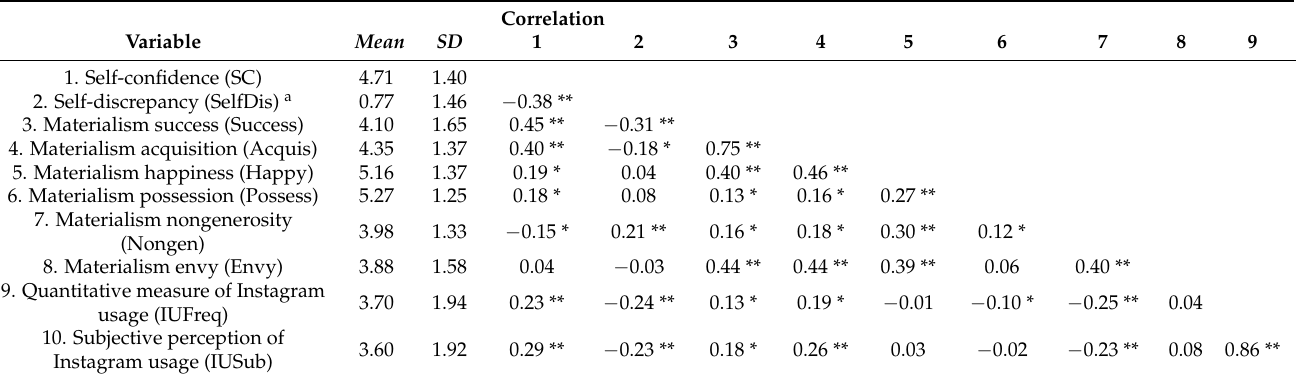
Table 2. Study 1: Means, standard deviations (SDs), and correlations (Pearson’s parametric correla- tion) of variables ( N =